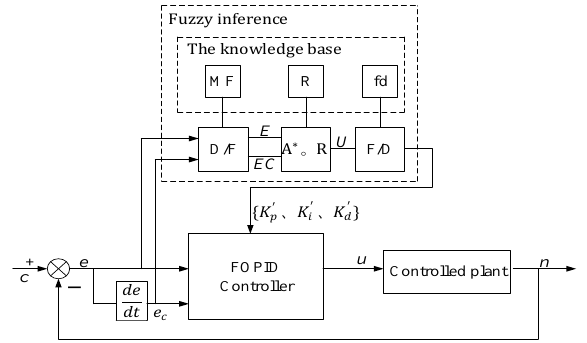
Figure 4. The structure of the fuzzy fractional-order PID controller.